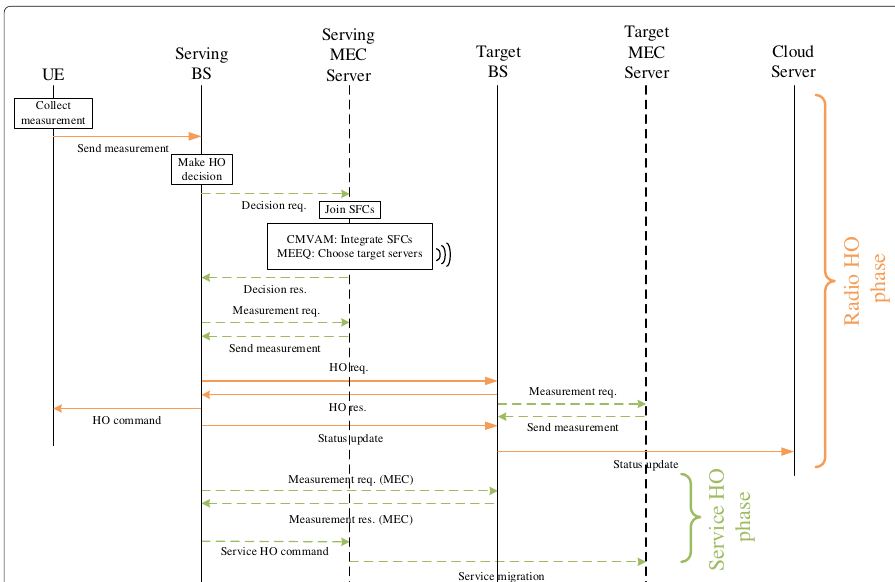
Fig. 4 The total HO and migration signaling. This is the total handover (HO) and migration signaling based on dynamic service migration with the CMVAM. In the procedure, handover decision and some related configuration work are performed by the MEC server instead of the involved UE or BSs (as LTE generally does). The advantage of this approach is to avoid the redundant signaling interaction between the UE and the BSs, hence the handover latency is effectively reduced. This is the advantage of MEC, which can execute and migrate services with lower latency, while the estimated mean value of such latency in the existing